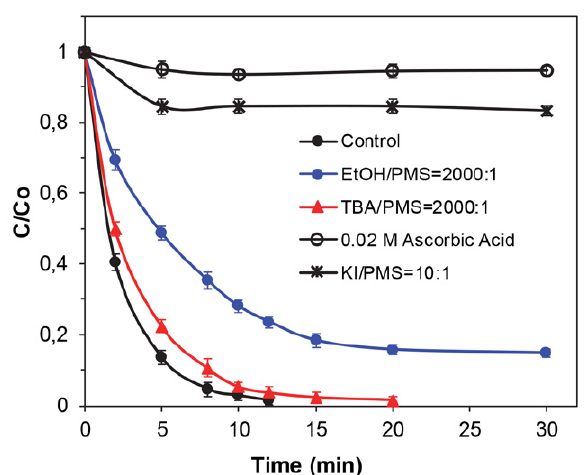
Fig. 15. Effect of radical scavengers on AO7 degradation. Reaction conditions: [AO7] o = 50 mg/L; [PMS]/[AO7] = 6; [Catalyst] = 0.1 g/L; initial pH = 3.04; T = 293